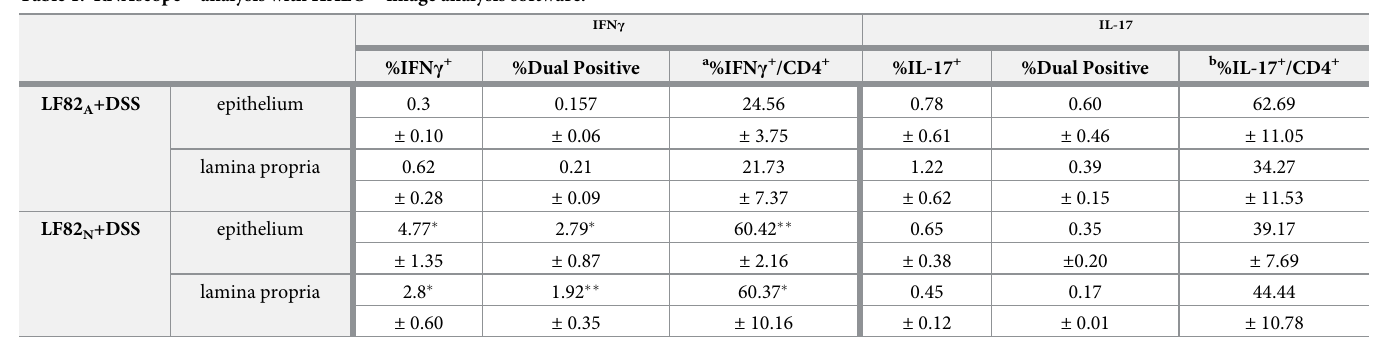
Table 1. RNAscope 1 analysis with HALO 1 image analysis software.